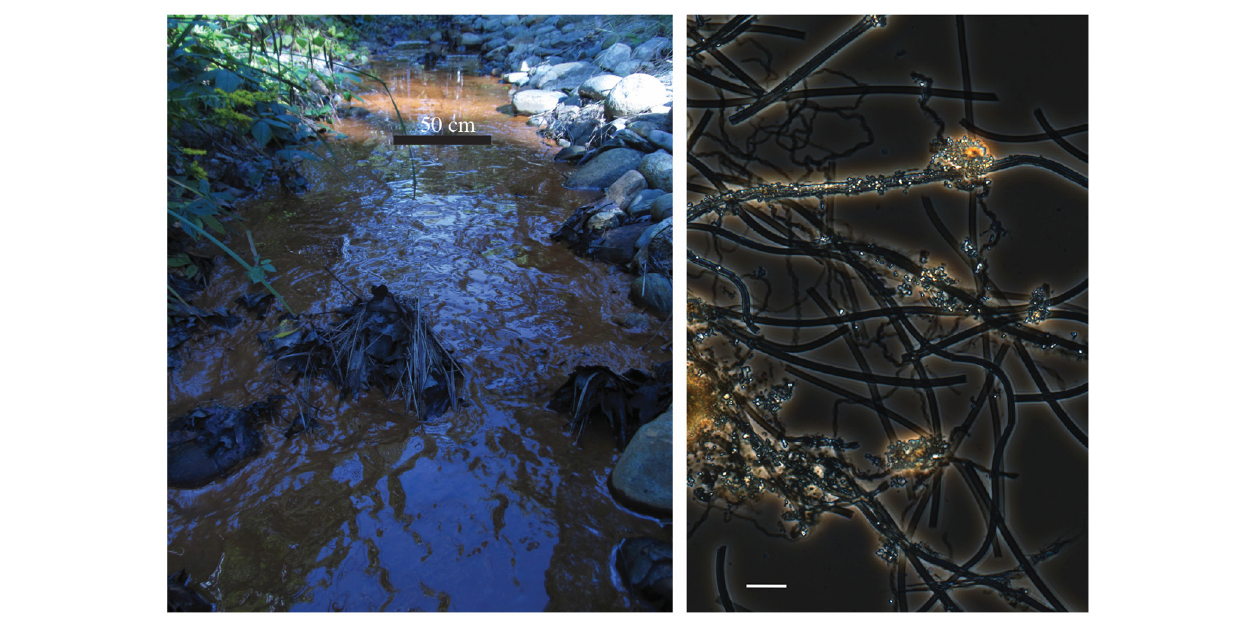
FIGURE 1 | The left panel shows a microbial iron mat forming in a ditch fed naturally by Fe(II)-rich water. This mat is 10–20cm deep, and its age is ∼ 3 weeks. The right panel is a photomicrograph showing FeOB taken from the same iron mat. Two common morphotypes of poorly crystalline iron oxyhydroxides are evident, long hollow tubular filaments produced by Leptothrix ochracea , and helical ribbons produced by Gallionella spp. The marker bar = 5 µ